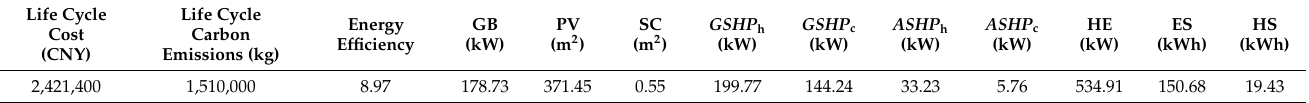
Table 3. Optimal compromise solution of single-level programming multi-objective optimization of the MCS. Life Cycle Life Cycle Cost Carbon (CNY) Emissions